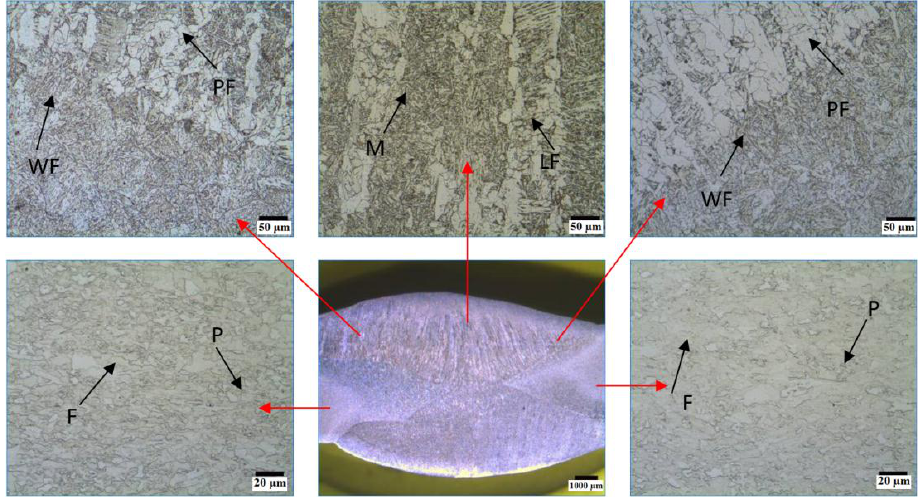
Figure 4. Microstructure of welded sample S3: ferrite (F), pearlite, (P), plate ferrite (LF), martensite (M), polygonal ferrite (PF) and witmanstaten ferrite (WF).